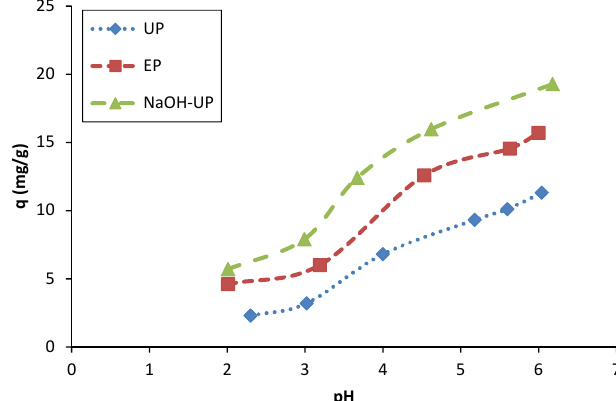
Fig. 5. Effect of solution pH on the adsorption of MG on UP, EP and NaOH-UP.